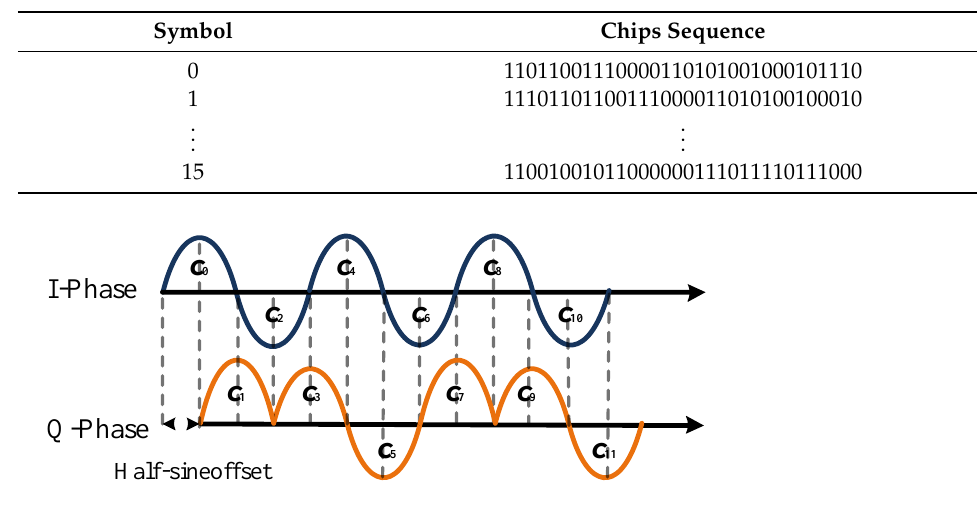
Figure 2. Half-Sine O-QPSK